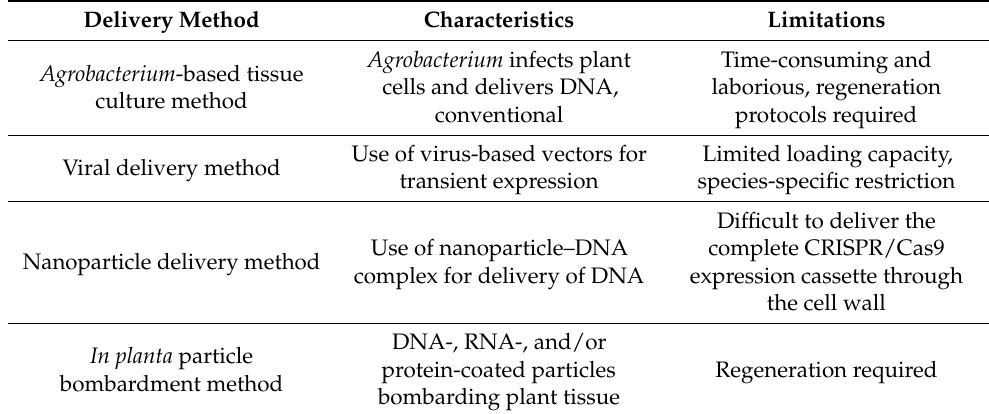
Table 2. Comparison of the delivery of the CRISPR/Cas9 expression